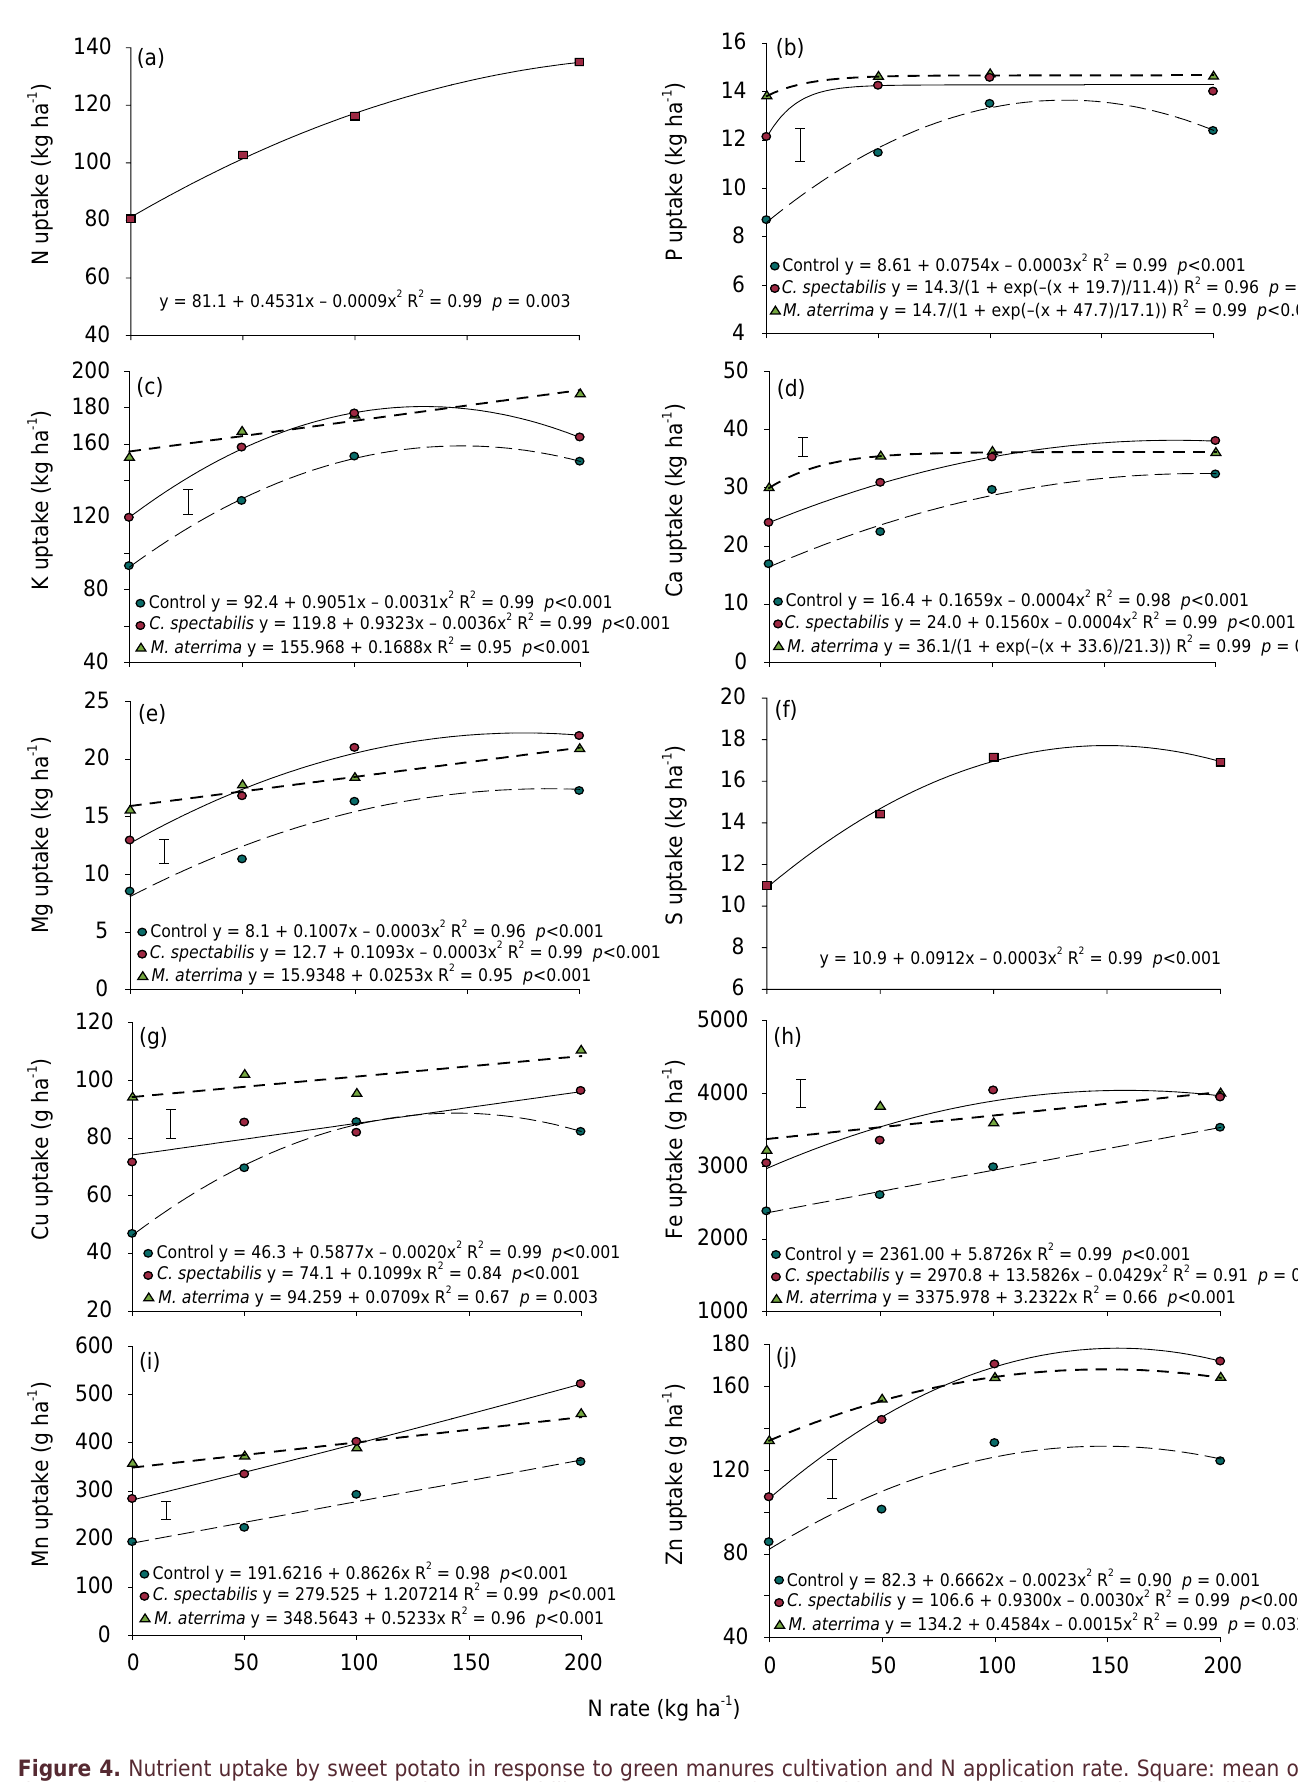
Figure 4. Nutrient uptake by sweet potato in response to green manures cultivation and N application rate. Square: mean of the three green manure treatments (Control, C. spectabilis , and M. aterrima ). Vertical bars represent the least significant difference at p ≤ 0.05 according to LSD test. Data are the means of the two agricultural